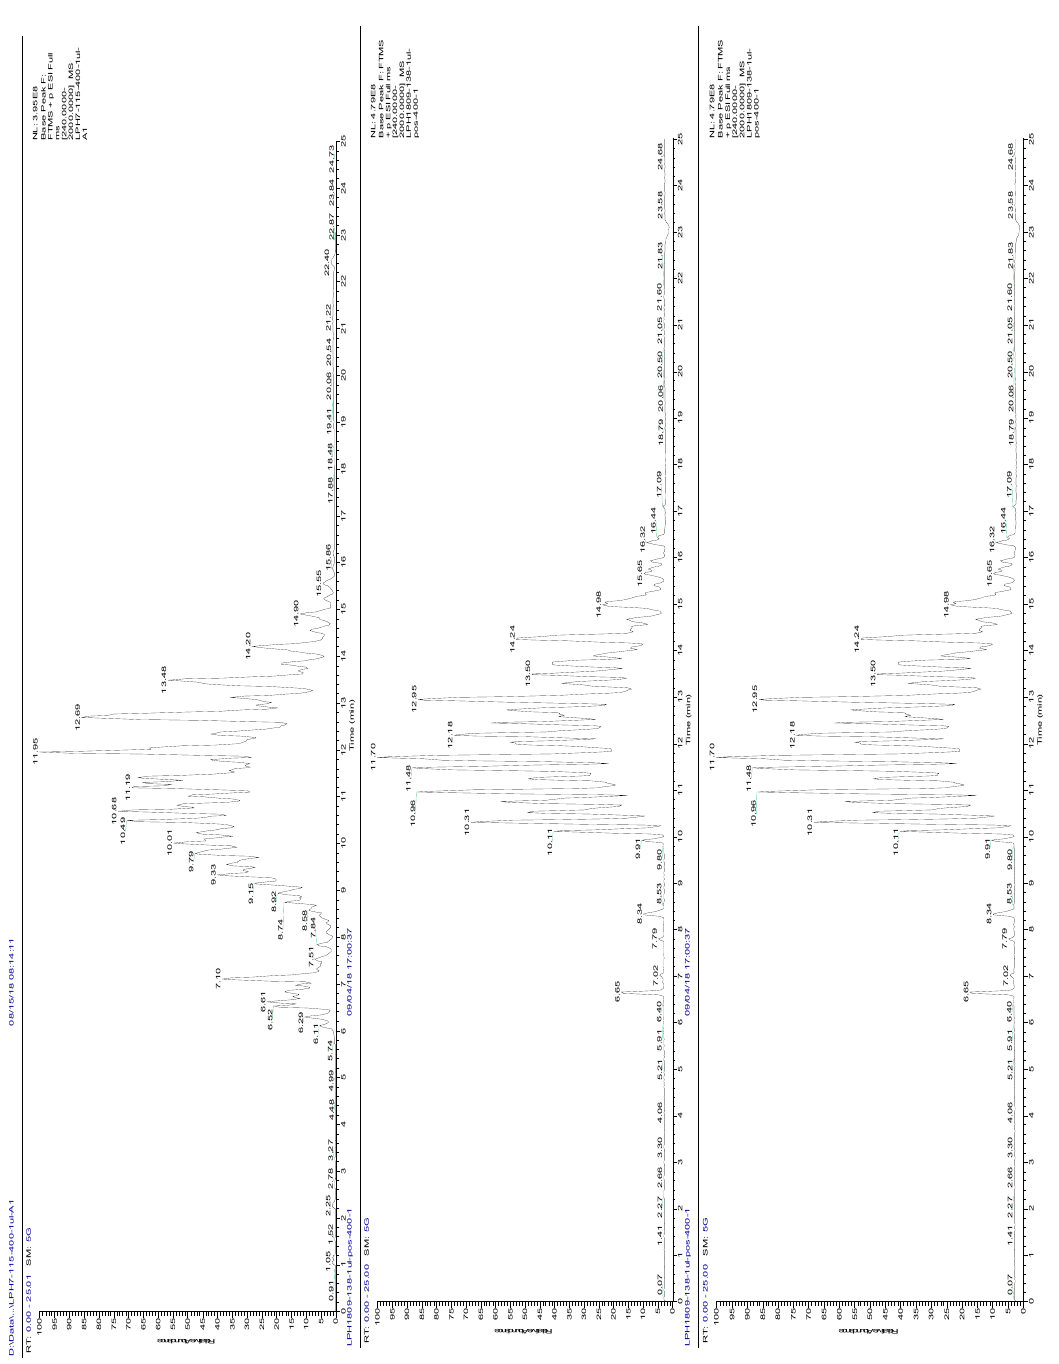
Figure 3. Total ion chromatogram of the three kinds of fish heads. Top, big eye tuna; middle, Atlantic salmon; bottom, bighead carp.